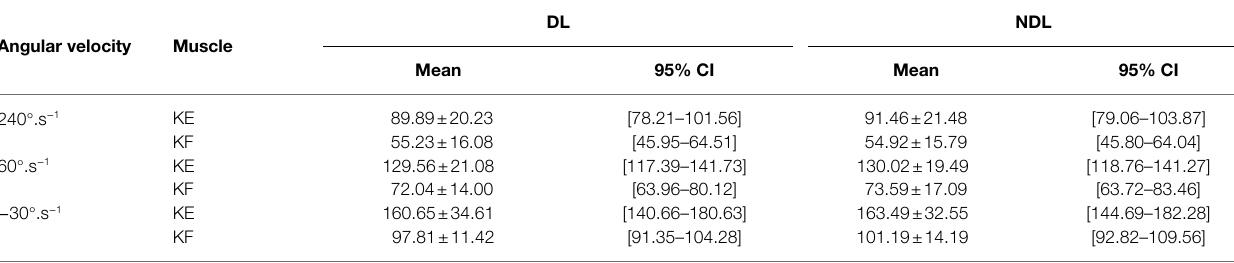
TABLE 1 | Peak torque (PT in N.m) of knee extensor (KE) and knee flexor (KF) in dominant leg (DL) and non-dominant leg (NDL).